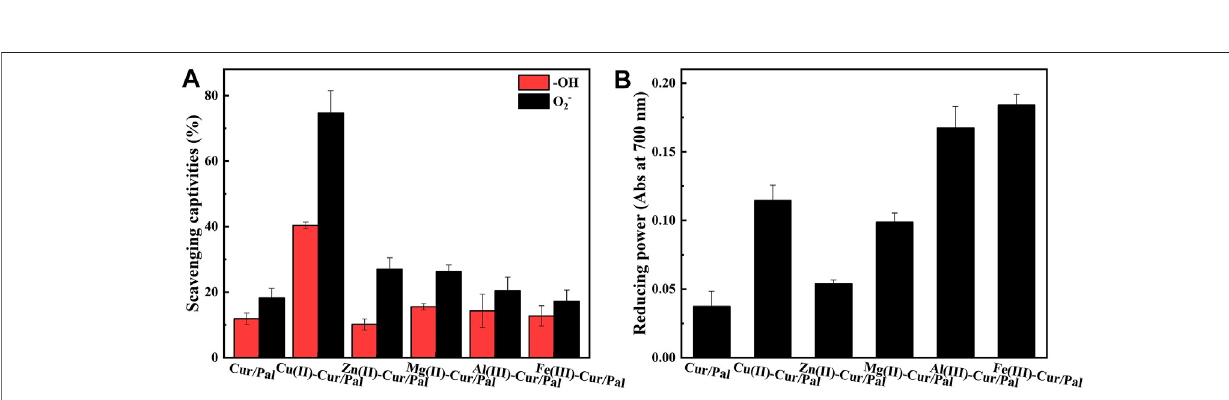
Frontiers in Chemistry |